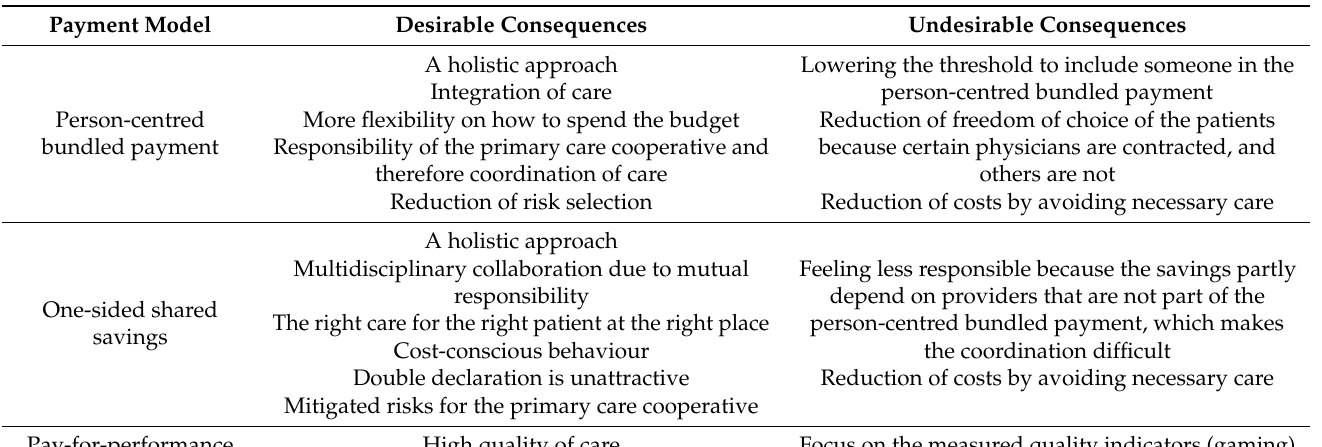
Table 3. Consequences which are generated by the proposed alternative payment